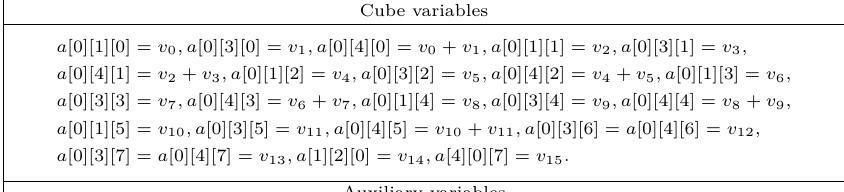
, n 0 ) is (1 , 15). The accumulated number of key bits recovered is a i